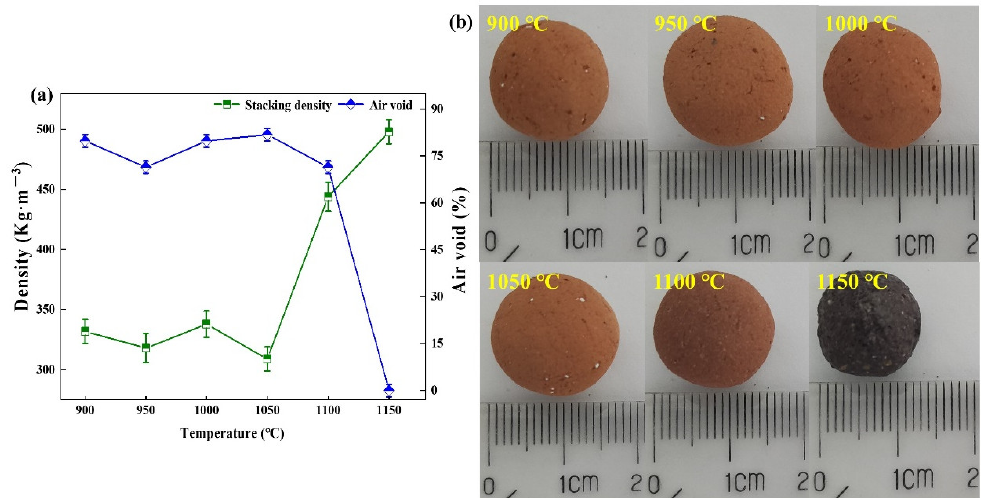
Figure 5. Effect of high temperature pyrolysis temperature on ceramsite (( a ) is stacking density and air void, ( b ) is a physical picture) .